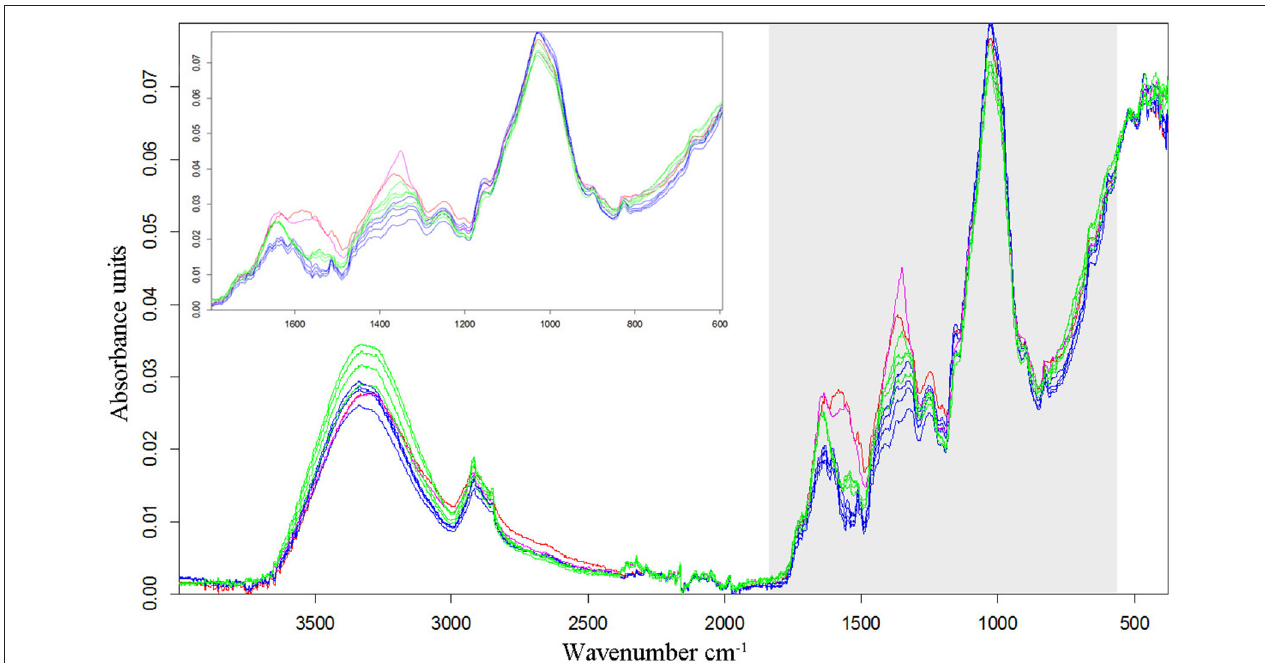
FIGURE 4 | Av-spectra of the maize cultivar 2 (Zm2) and the barnyard grass cultivar 5 (Ec5). The four maize Av-spectra of the root segments 0–75% are displayed in blue, the maize Av-spectra of the root segment 100% (root tip) is display in red. The four barnyard grass Av-spectra of the root segments 0–75% are displayed in green, the barnyard grass Av-spectra of the root segment 100% (root tip) is display in pink. Spectra are vector-normalized and offset-corrected. As detail the Av-spectra of the wavenumber 1,800–600 cm − 1 are